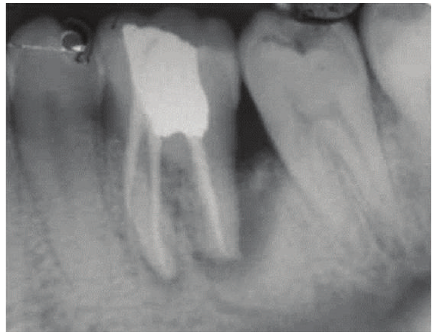
Figure 1: Diagnostic radiograph.